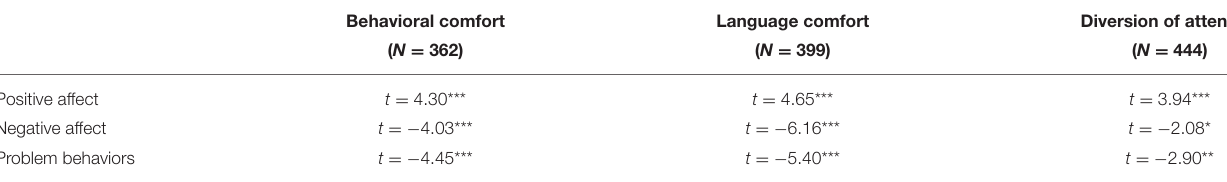
TABLE 3 | T -test of the effect of informal coping strategies and affect in children with intellectual